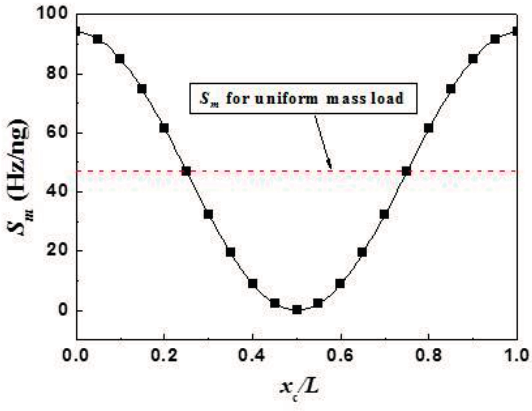
Figure 1. Simulated S m (solid squares) for the concentrated mass load at different locationsm ( x c ) for the MSP operated at the fundamnetal resonant mode. The parameters of the MSP is listed in Table 1. The numerical simulation is done for a mass load of M* = Δ m/M = 10 − 5 . The solid line is the fitting